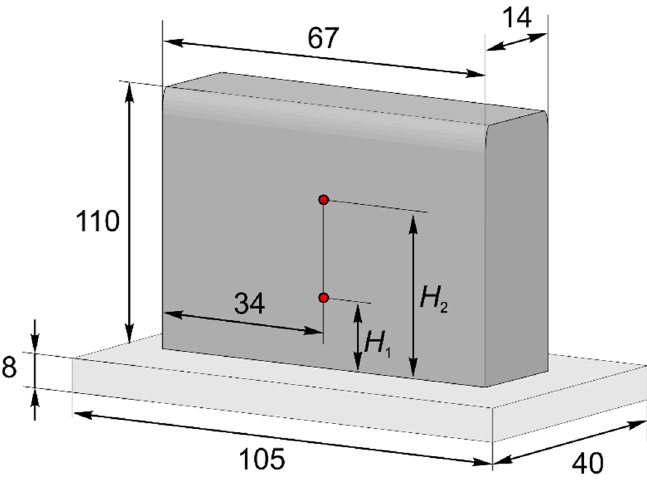
Figure 7. The size of the deposited sample and the location of the thermocouple attachment